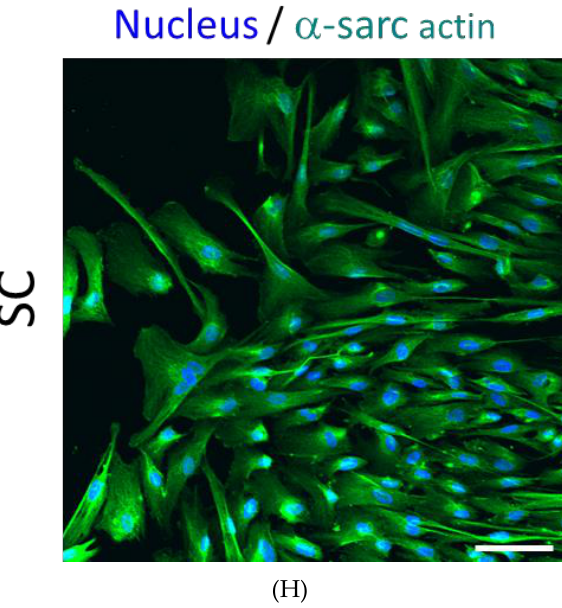
Figure 2. PEPCs are highly proliferating cells and express cardiac lineage potential after in vitro culture. ( A ) Spindle-like cells and cardiosphere-like cell clusters appeared 7 days after cell seeding. ( B ) Day 14 culture showed robust growth of spindle cells and cardiospheres. ( C ) FACS analysis, either from day 1 (D1) or day 2 (D2) drain fluid collections, showed increased expression of stem cell factor receptor (CD117), CD90, and CD105 after 6 cell passages (D1 – P6, D2 – P6) compared with their corresponding primary cells (D1 and D2). ( D ) The expression of CD31, CD34, CD45, and CD133 decreased with increased cell passages (* p < 0.05, ** p < 0.01, *** p < 0.001). ( E ) Differential interference contrast (DIC) image of cultured human PEPCs showed two distinct cell morphologies: cardiosphere-like (CS) and spindle-like cell (SC) on the fibronectin-coated plate. ( F ) and ( G ) Confocal immunofluorescence images of CS and SC cells stained with CD117, connexin (CX) 43, Ki67, CD105, ( H ) α -sarcomeric actin. Nuclei were counterstained with 4', 6-diamidino-2-phenylindole (DAPI). Scale bar = 200 μm in E and G, and scale bar = 50μm in H.